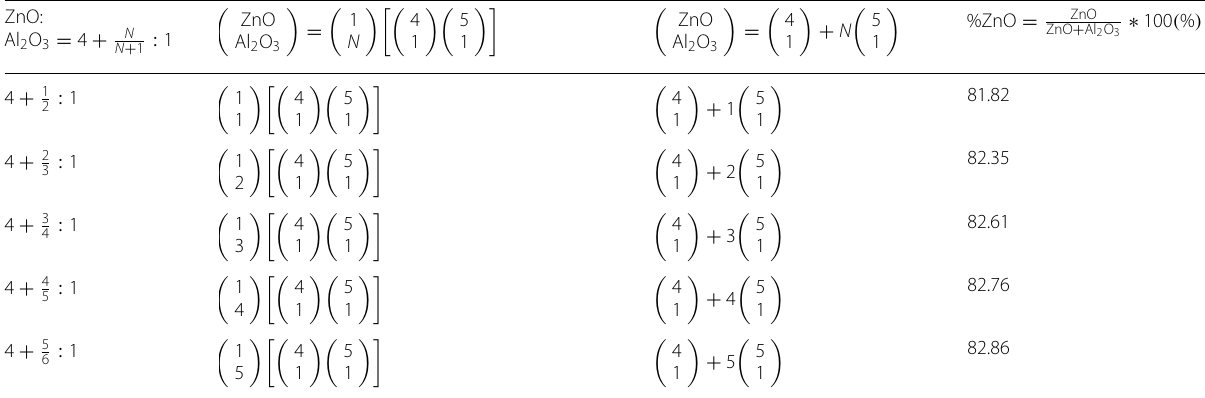
Table 1 Detailed ALD experimental parameters for the AZO conductive